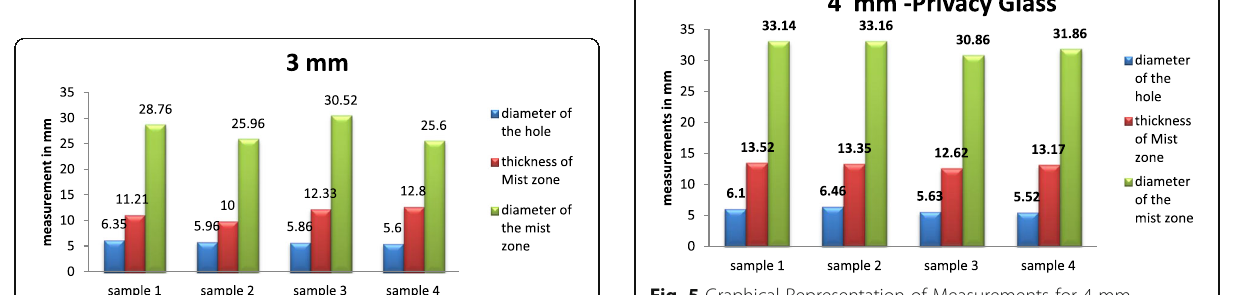
Fig. 5 Graphical Representation of Measurements for 4 mm Privacy